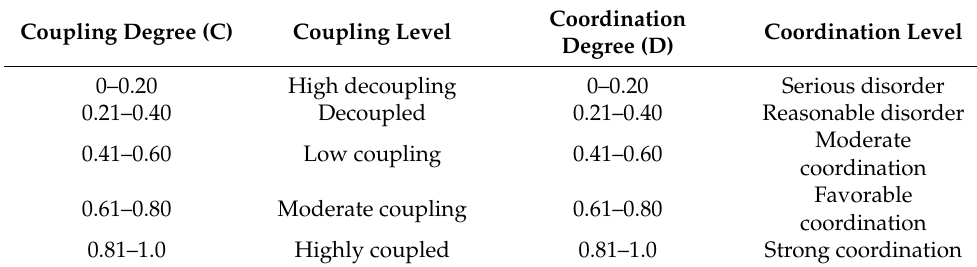
Table 2. Types of coupling degree and coordination degree.